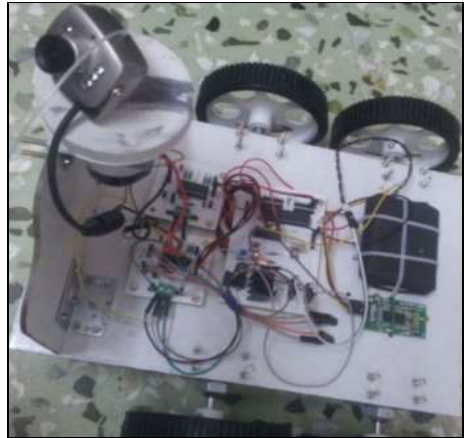
Fig. 3. War Field Robot With Wireless Night Vision Camera